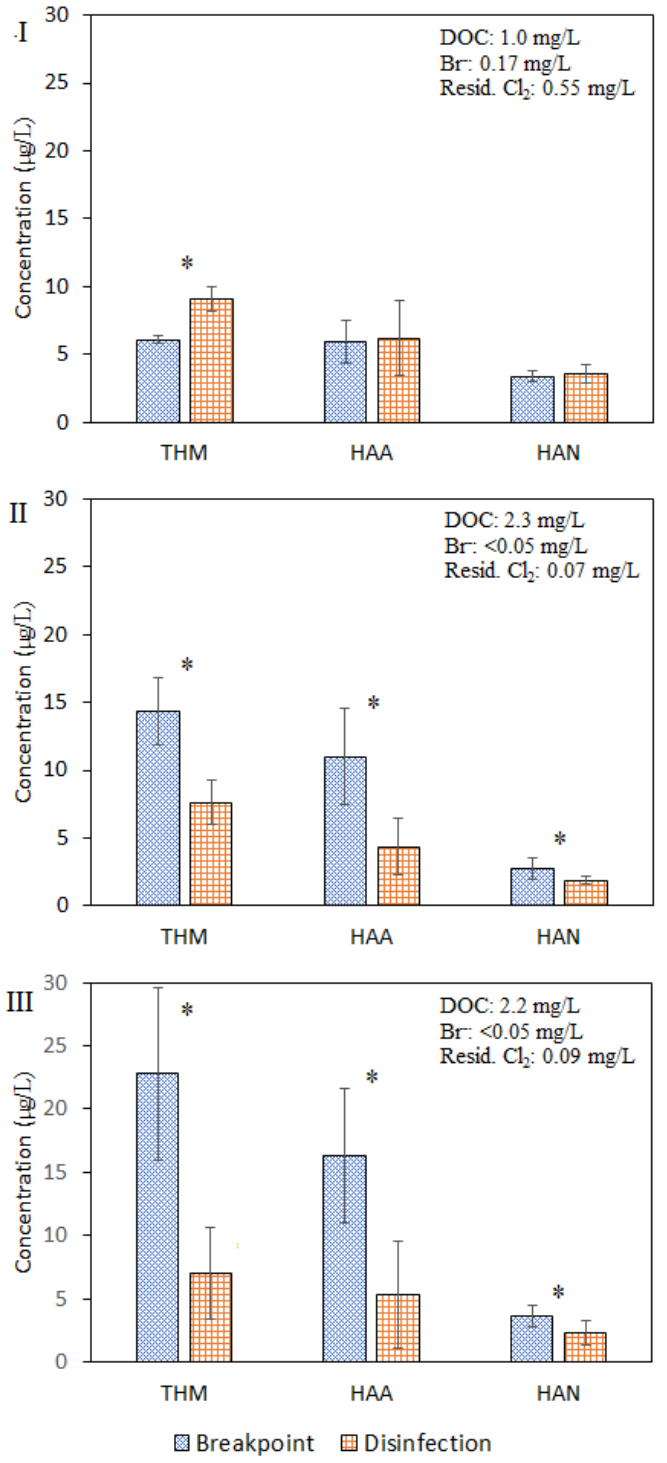
Figure 2. Concentration of DBPs generated during BC and disinfection at waterworks I – III (* significant difference between BC and disinfection at significance level 0.05).